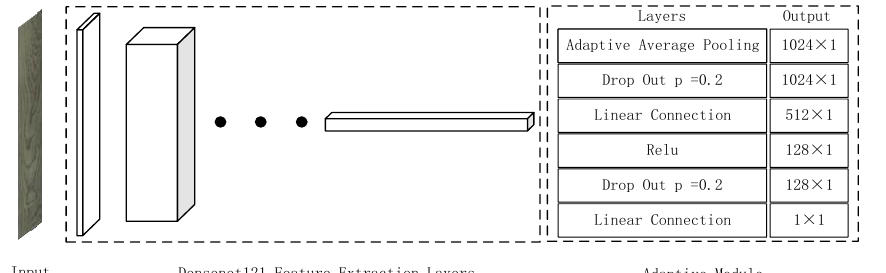
Figure 8. Improved Densenet121 network architecture.